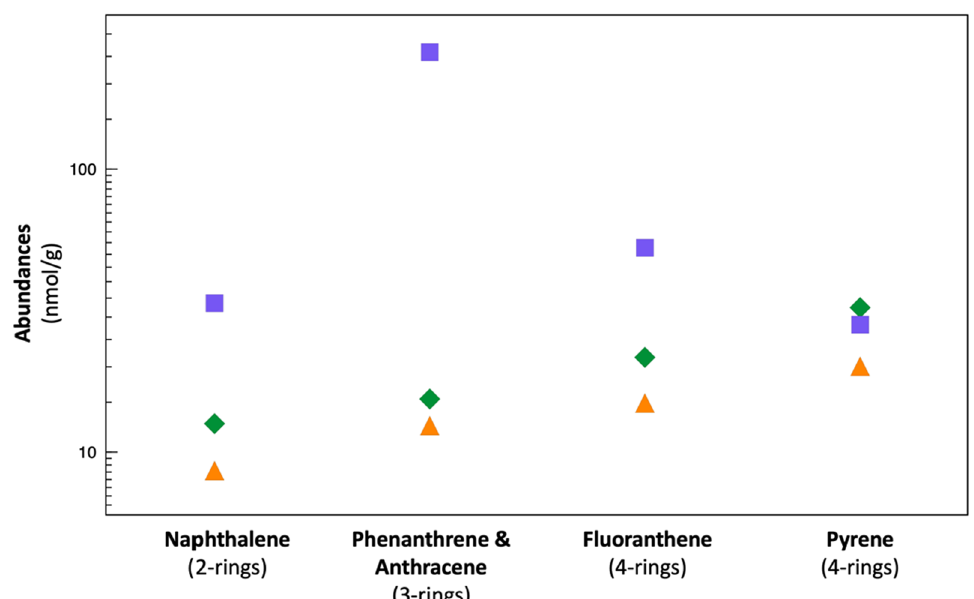
Fig. 2 Comparative abundances of the PAHs in the DCM extracts of samples A0106, C0107 and Orgueil (naphthalene m/z 128.0621 coeluting phenanthrene and anthracene